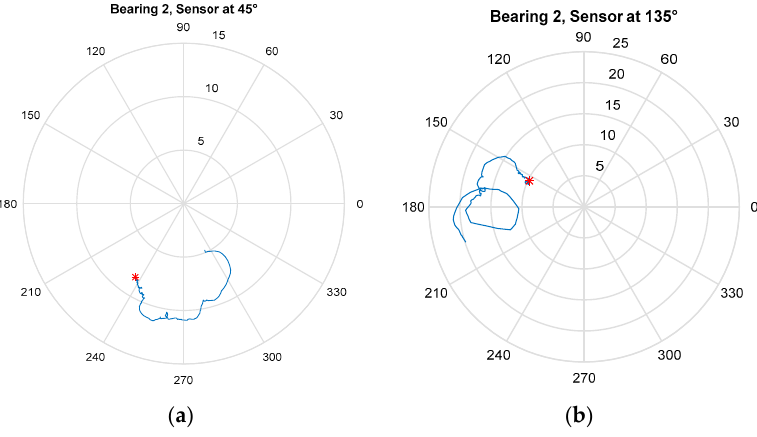
Figure 9. Polar diagram at ( a ) 45 ◦ and ( b ) 135 ◦ in bearing 2 of turbogenerator field ( µ m )